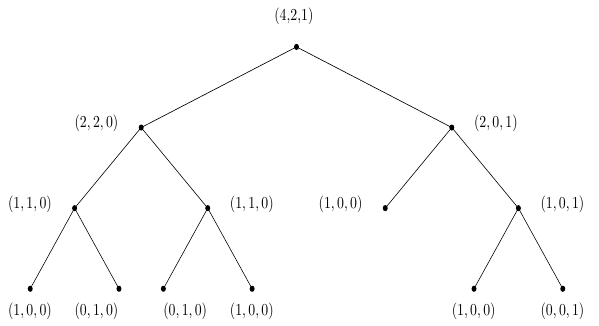
Figure 4: A Huffman labeling of the same full binary tree in Figures 2 and 3, for a JL-coloring of K 4 , 2 ,